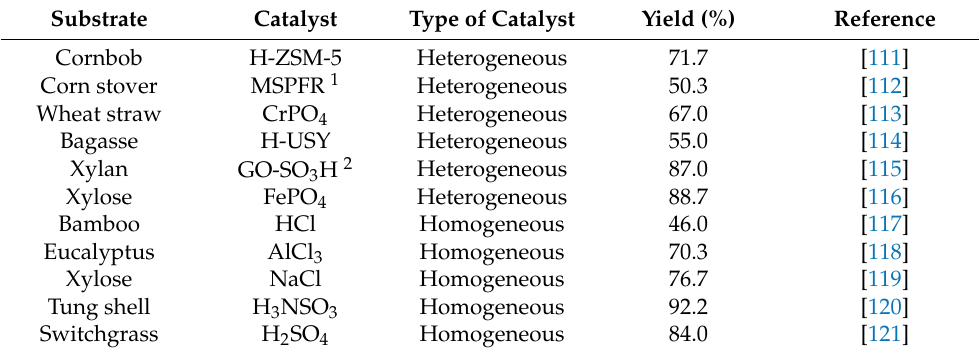
Table 4. Application of heterogeneous and homogeneous catalysts in furfural production from different substrates (adapted from Ye et al.)